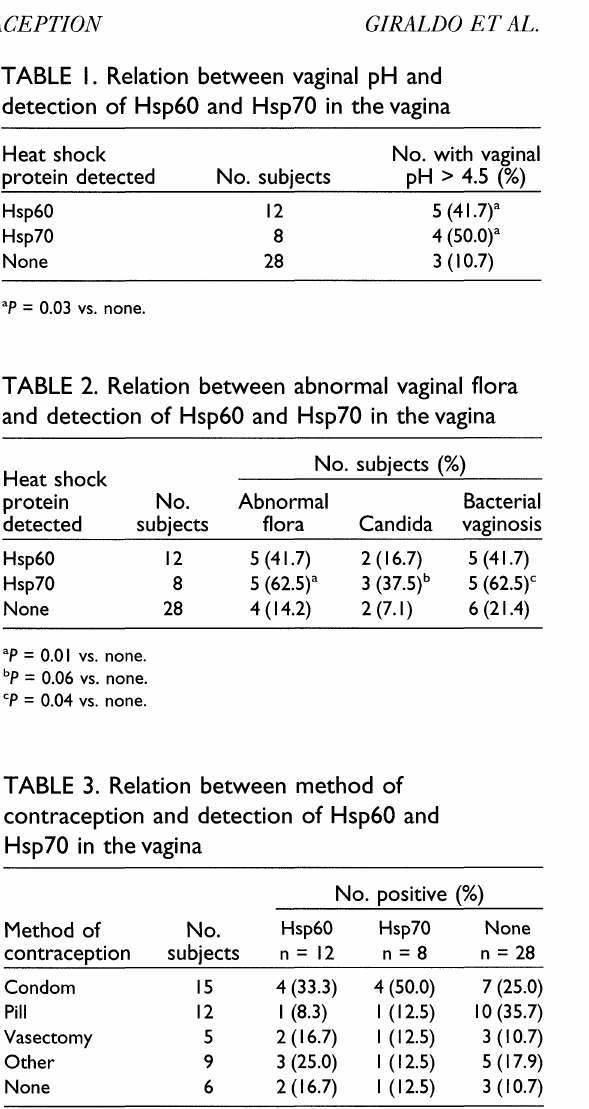
TABLE 3. Relation between method of contraception and detection of Hsp60 and Hsp70 in the